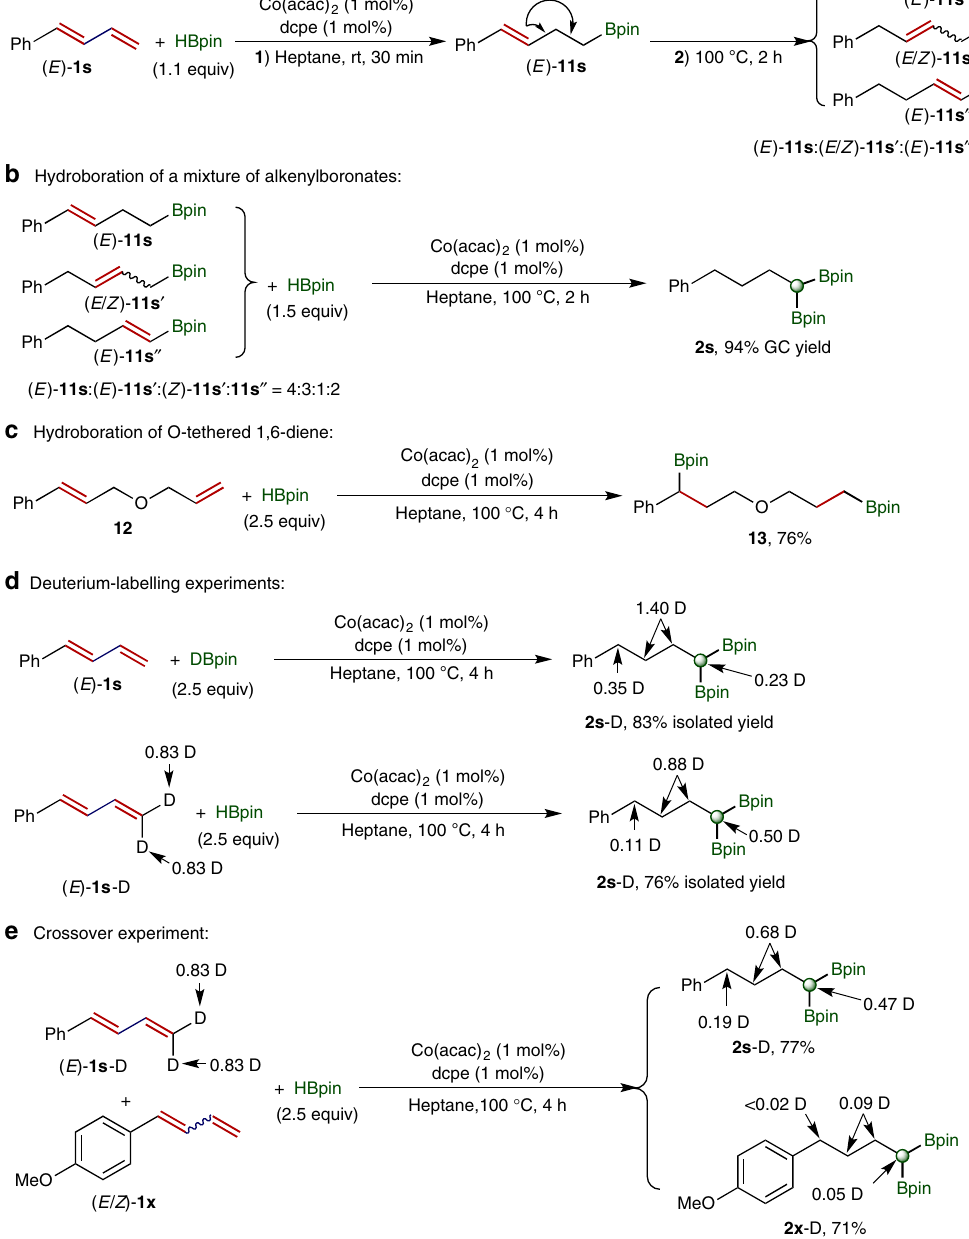
Fig. 6 Deuterium-labeling experiment and control experiments. a Monohydroboration of diene 1s and isomerization of alkenylboronate ( E )-11s. b Hydroboration of a mixture of alkenylboronates. c Hydroboration of O-tethered 1,6-diene 12 . d Deuterium-labeling experiments. e Crossover